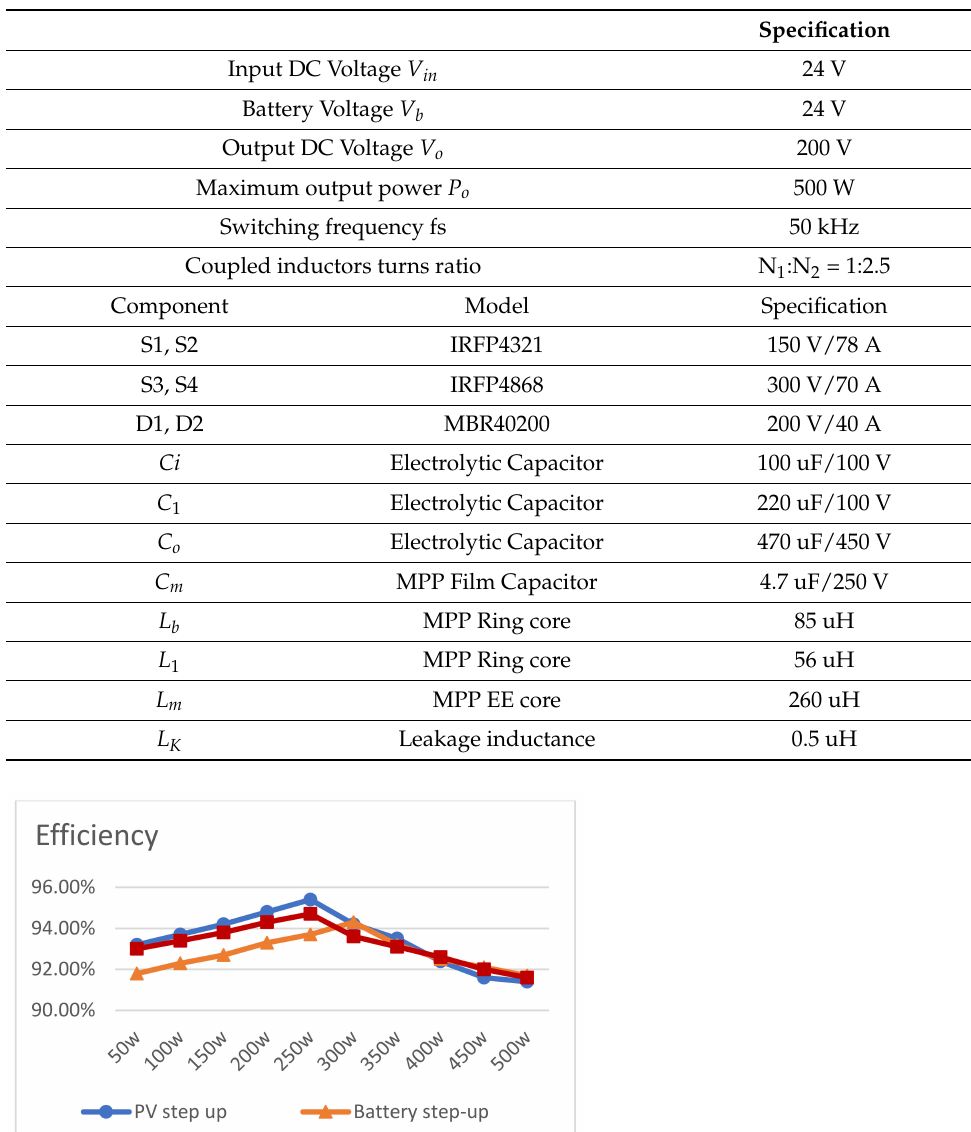
Figure 10. Photographs of the proposed three-port bidirectional DC/DC converter. Table 3. Electrical specifications and component parameters of the proposed converter.